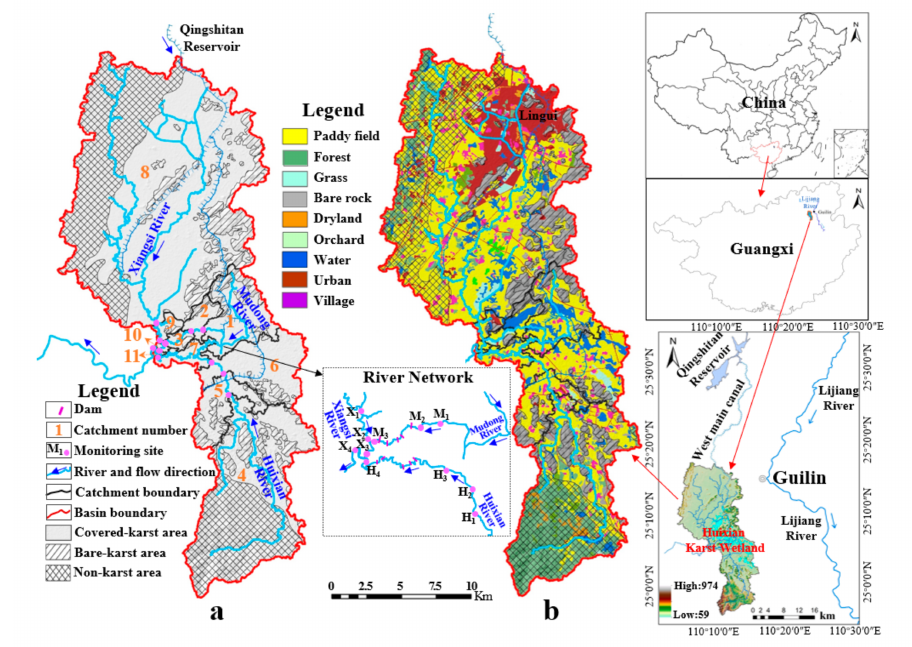
Figure 1. Map of the Huixian karst wetland basin showing ( a ) distribution of the eleven sampling sites (M 1 –M 3 , H 1 –H 4 and X 1 –X 4 ) and the eleven catchments (1–11); and ( b ) the land use